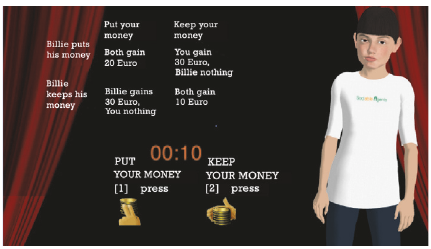
Figure 2: Prisoner’s